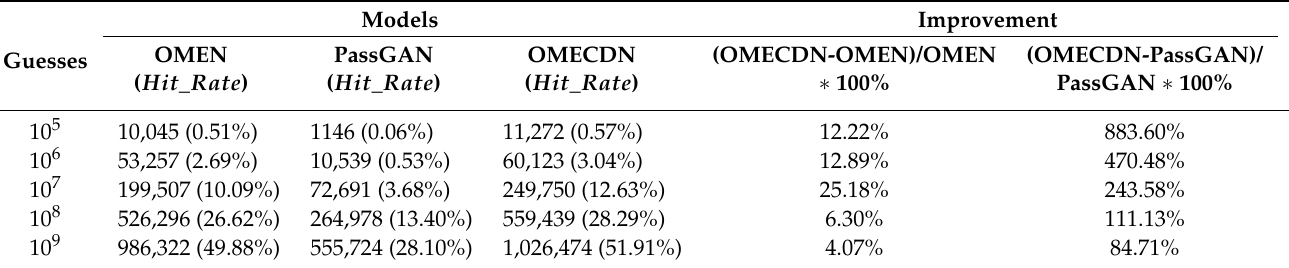
Table 3. Hits of the three